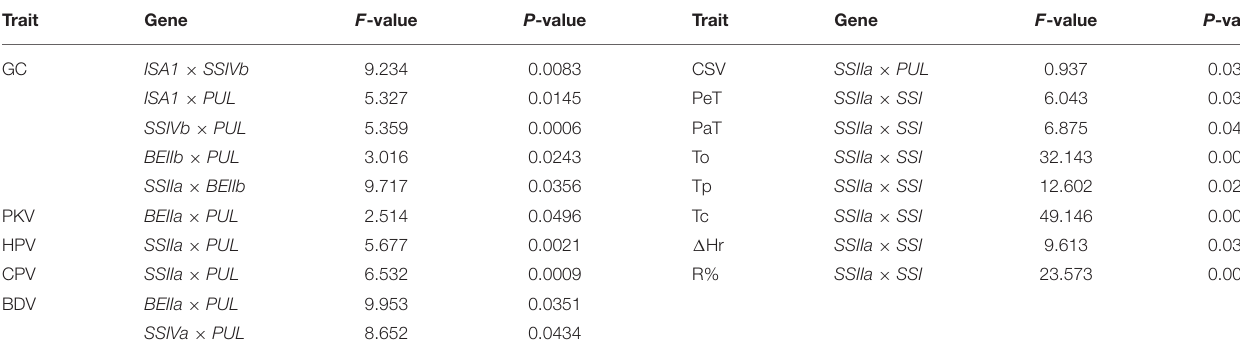
TABLE 5 | The interaction effects of SSRGs in glutinous